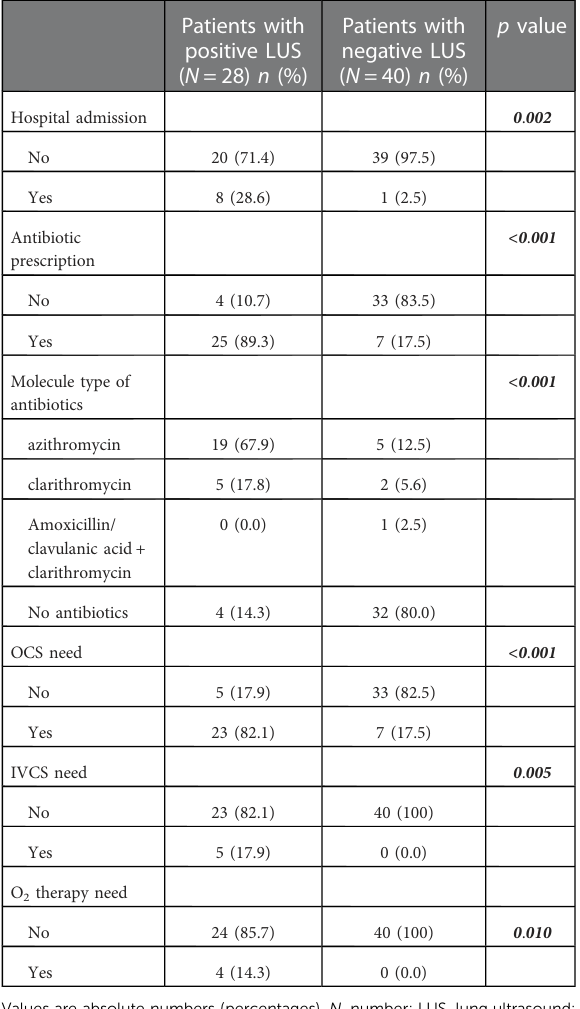
TABLE 3 Clinical course and hospital resource use of the patients with positive lung ultrasound. Patients with positive LUS